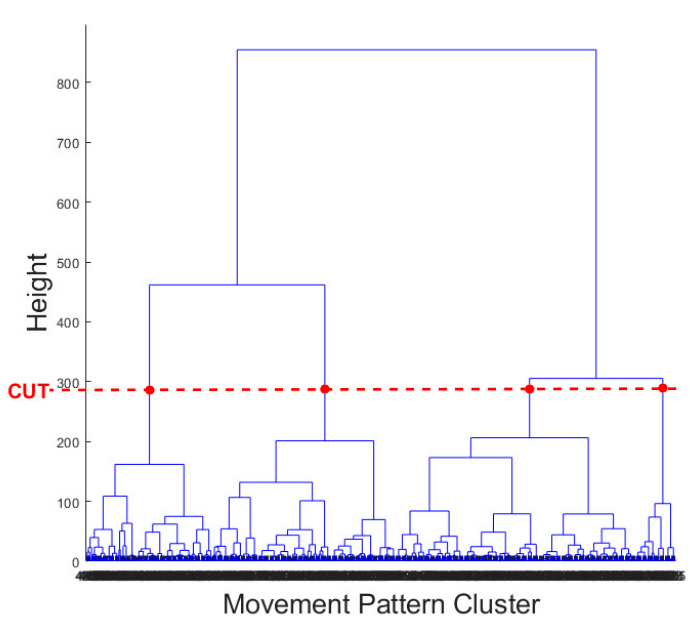
Figure 9. Dendrogram of output hierarchical tree (red dashed line indicates a cut point to form four clusters).